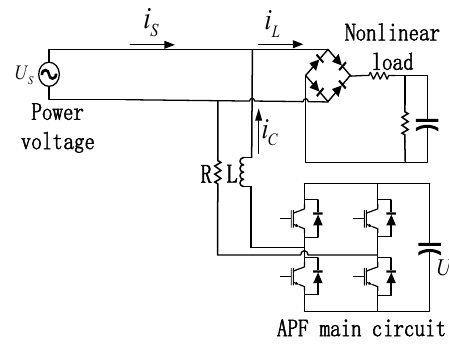
Figure 3. Circuit model diagram of the APF system.